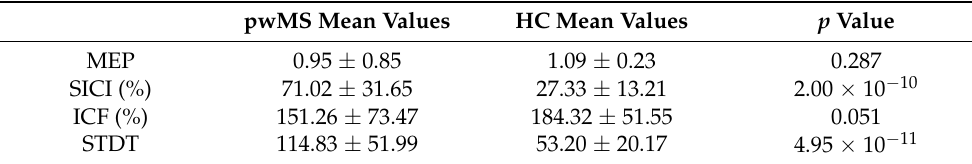
Table 3. Neurophysiological parameters of people with multiple sclerosis and healthy